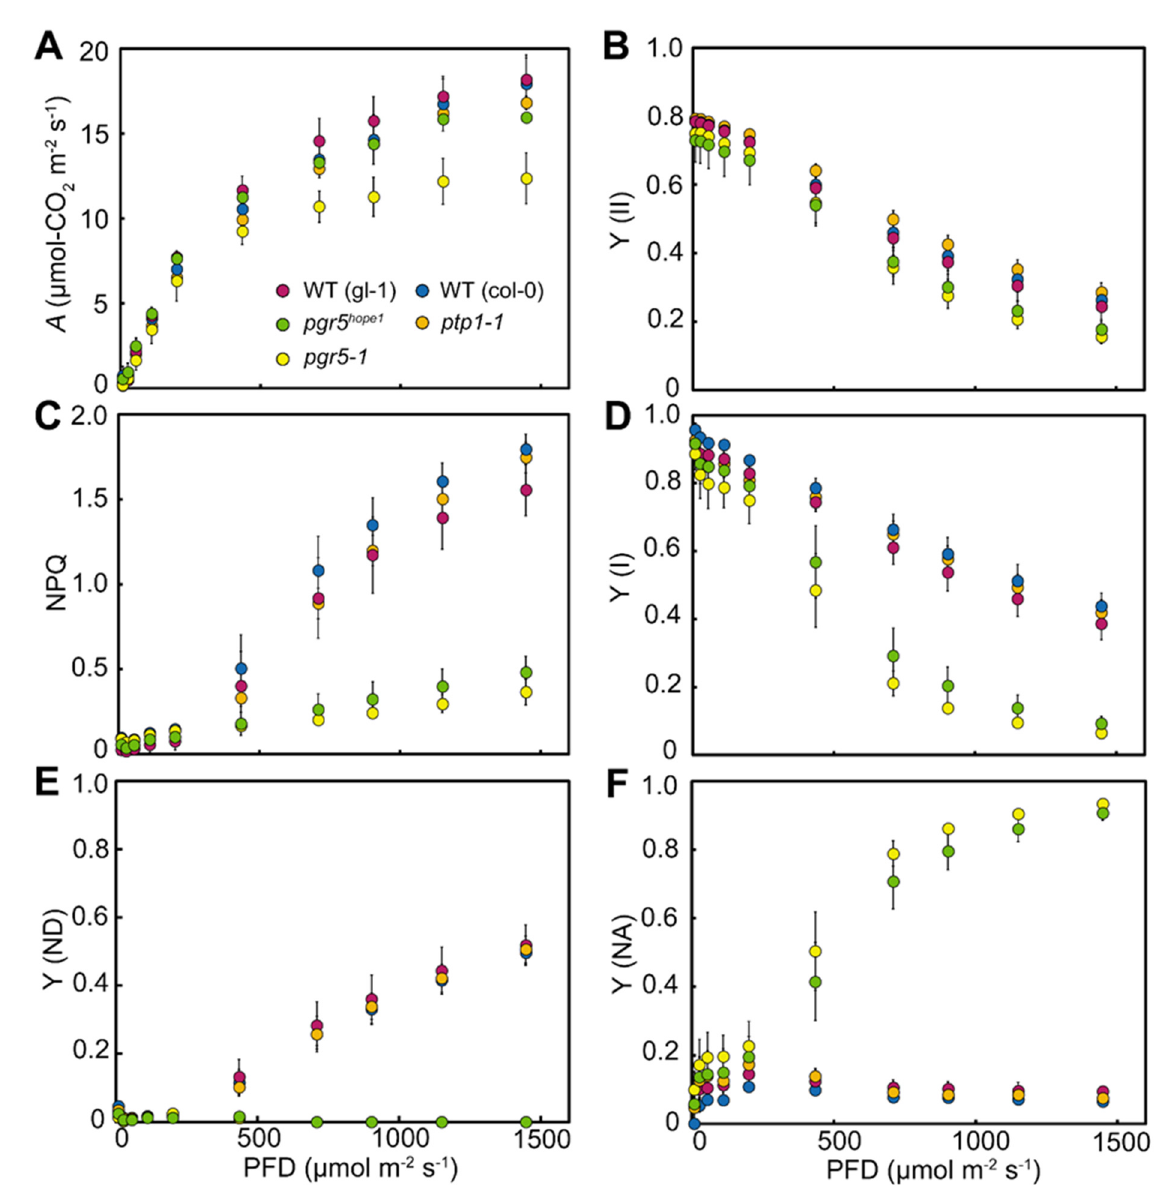
Figure 5. The photosynthetic capacity in pgr5-1 , pgr5 hope1 and ptp1-1 . Light intensity-dependent changes in photosynthetic parameters; ( A ), CO 2 fixation rate, ( B ), the quantum yield in PSII (Y(II)), ( C ), non-photochemical quenching, ( D ), the quantum yield in PSI (Y(I)), ( E ), the ratio of oxidized P700 (P700 + ) in PSI (Y(ND)), ( F ), the ratio of excited P700 (P700*) in PSI (Y(NA)). Magenta, blue, green, yellow and orange are wild-type gl-1, wild-type Col-0, pgr5 hope1 , pgr5-1 and ptp1-1 , respectively. Data are means ± sd ( n = 5). Experiments were independently repeated at least 3 times with similar results. Graphs show representative results. The results of statistical analysis of these data are summarized in the Supplementary Table S4.